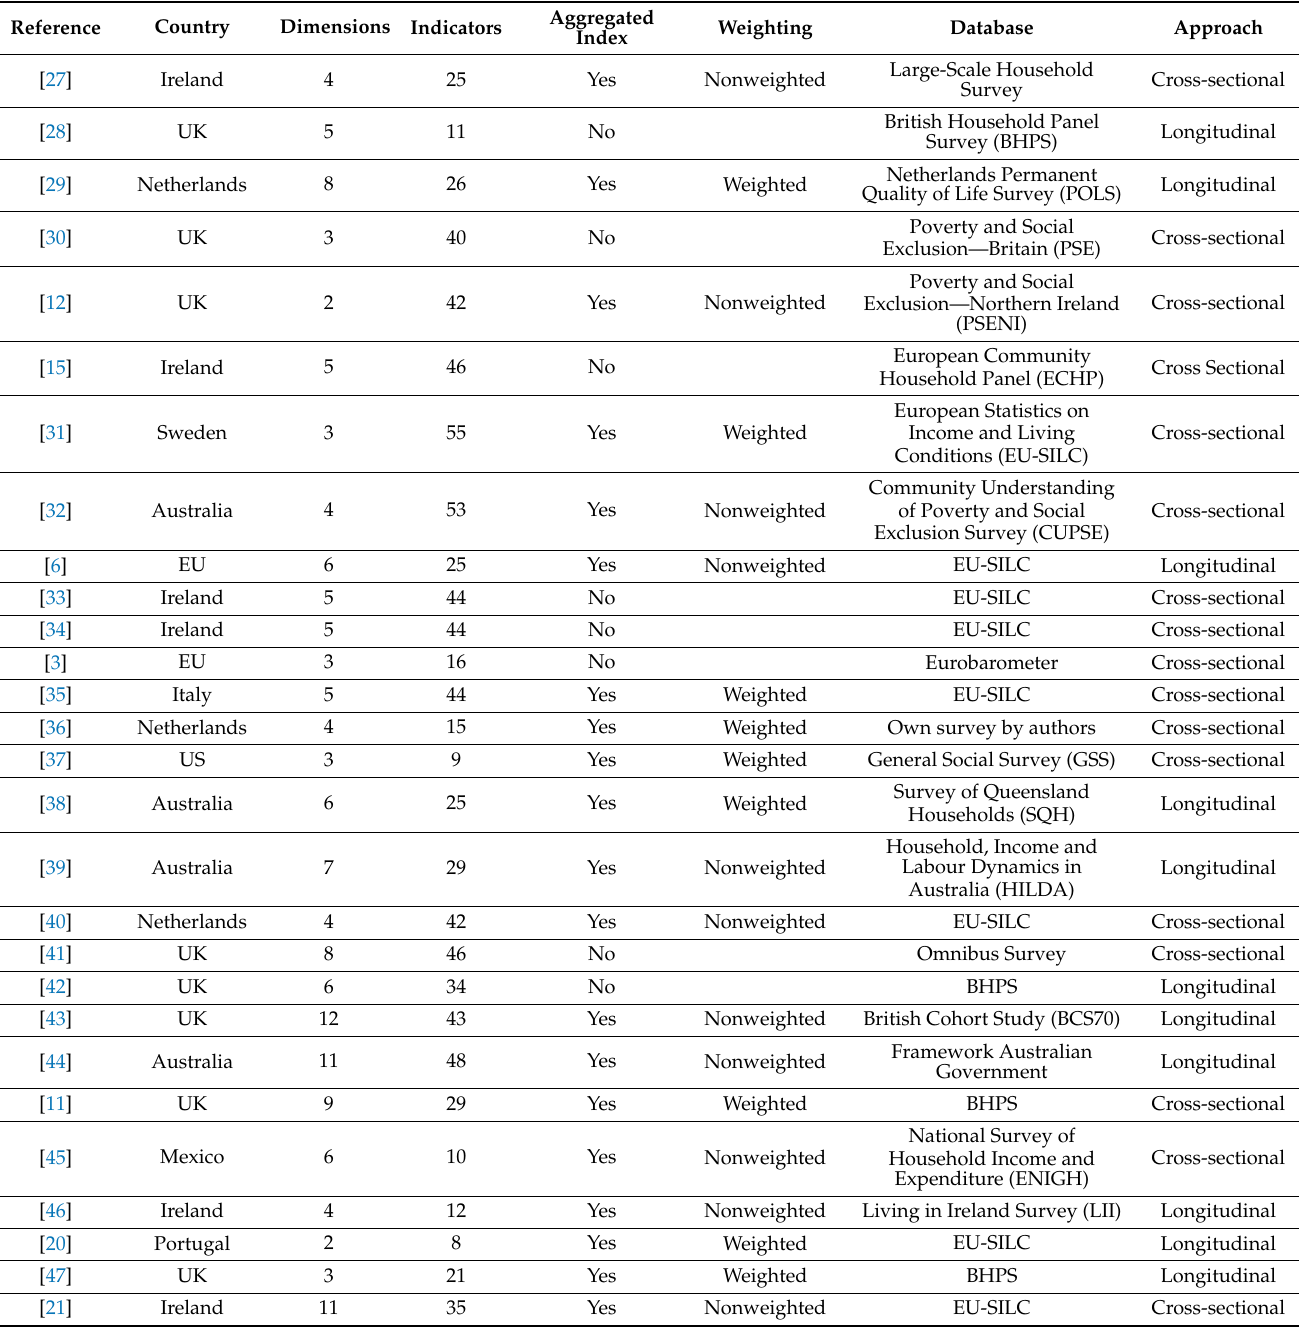
Table 3. Systematization of the multidimensional measures of social